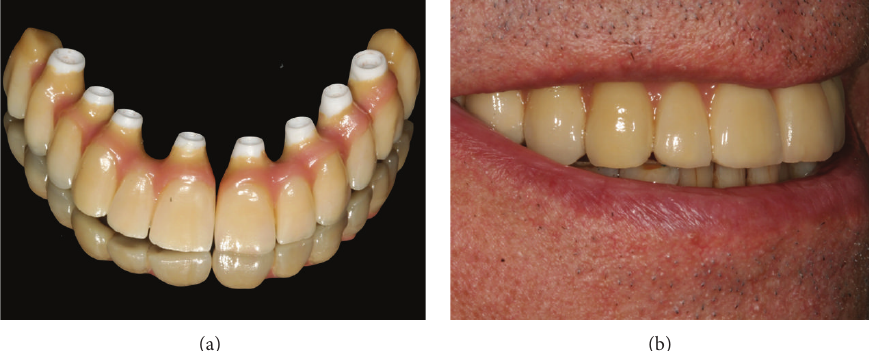
Figure 7: Final prosthesis. (a) Fixed ceramic one-piece prosthesis (Procera Implant Bridge Zirconia, Nobel Biocare AB). (b) Final extra oral